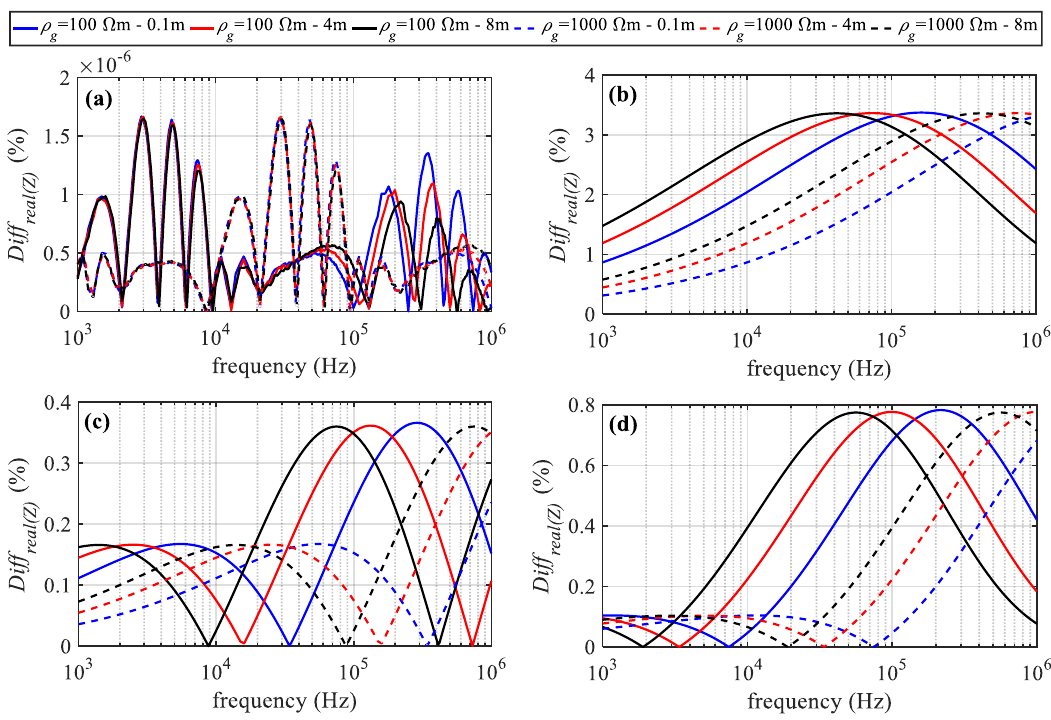
Figure 13. Di ff erences in the real part of Z 13 in NB using the closed-form expression of ( a ) Carson, ( b ) Dubanton ( c ) Noda and ( d ) Alvarado-Betancourt.